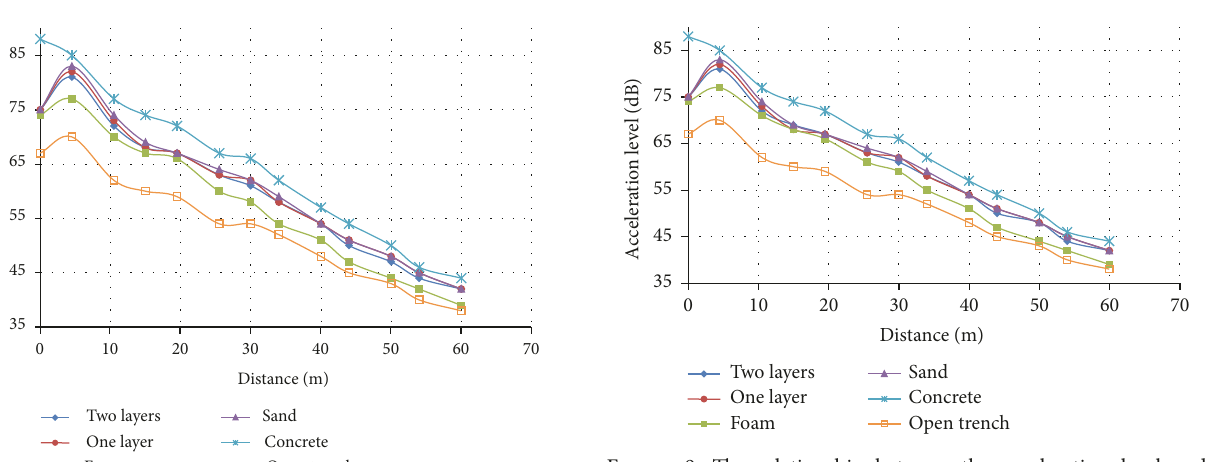
Figure 9: The relationship between the acceleration level and distance under case 4 .